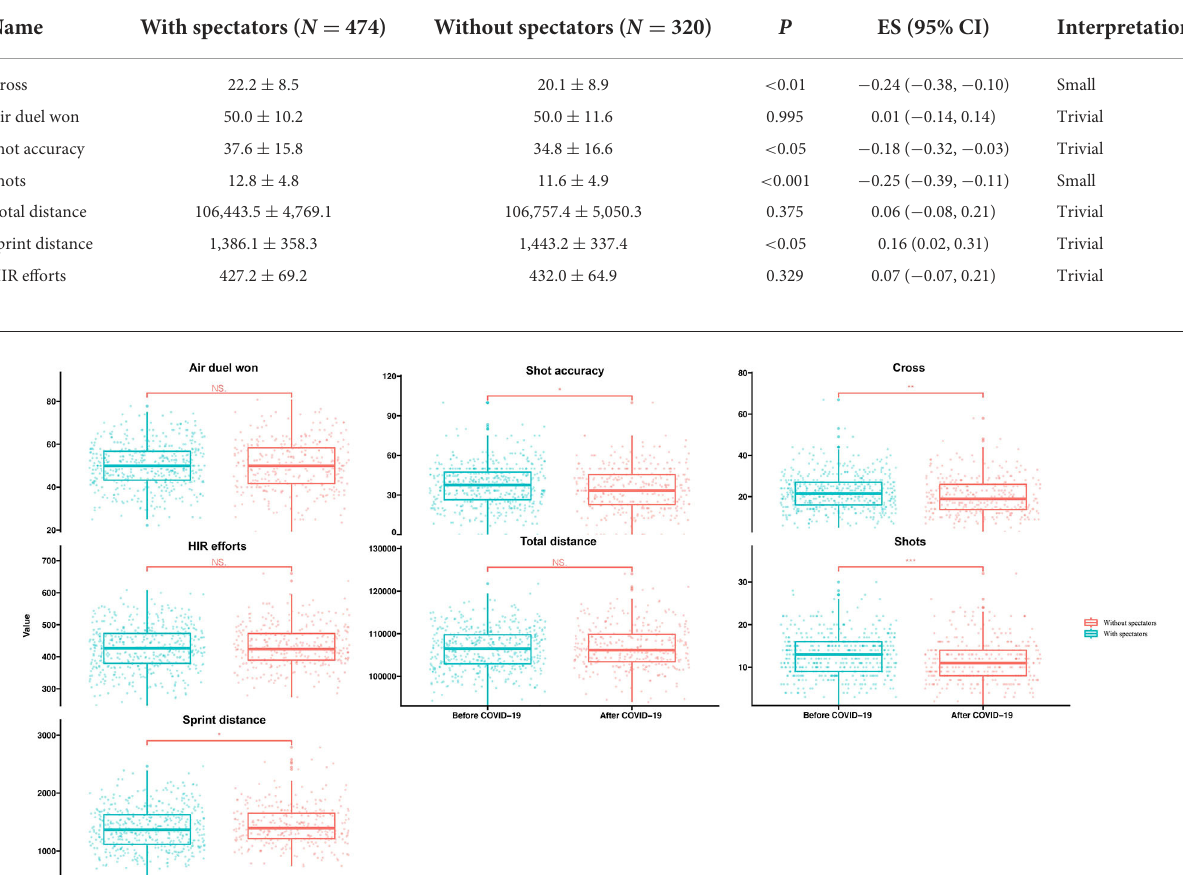
with winning probability, such as cross (OR, 1.08; 95% CI, 1.04– 1.12; p < 0.001), shot accuracy (OR, 0.95; 95% CI,